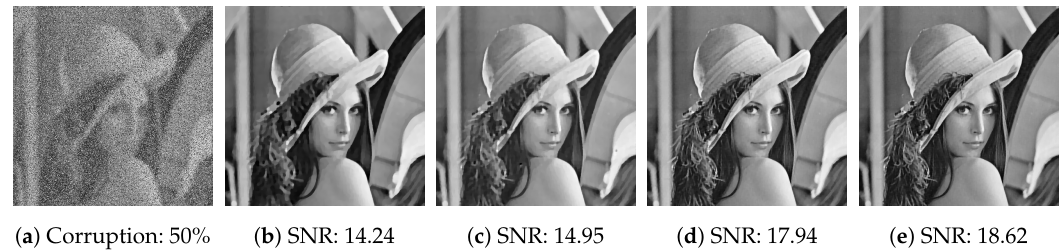
Figure 13. Comparisons of TVL1, HTVL1, CTVL1 and HOCTVL1 model on the Lena image corrupted by Gaussian blur and random-valued noise with noise level 50%. ( a ) Corrupted image. ( b ) TVL1 model. ( c ) HTVL1 model. ( d ) CTVL1 model. ( e ) HOCTVL1 model.